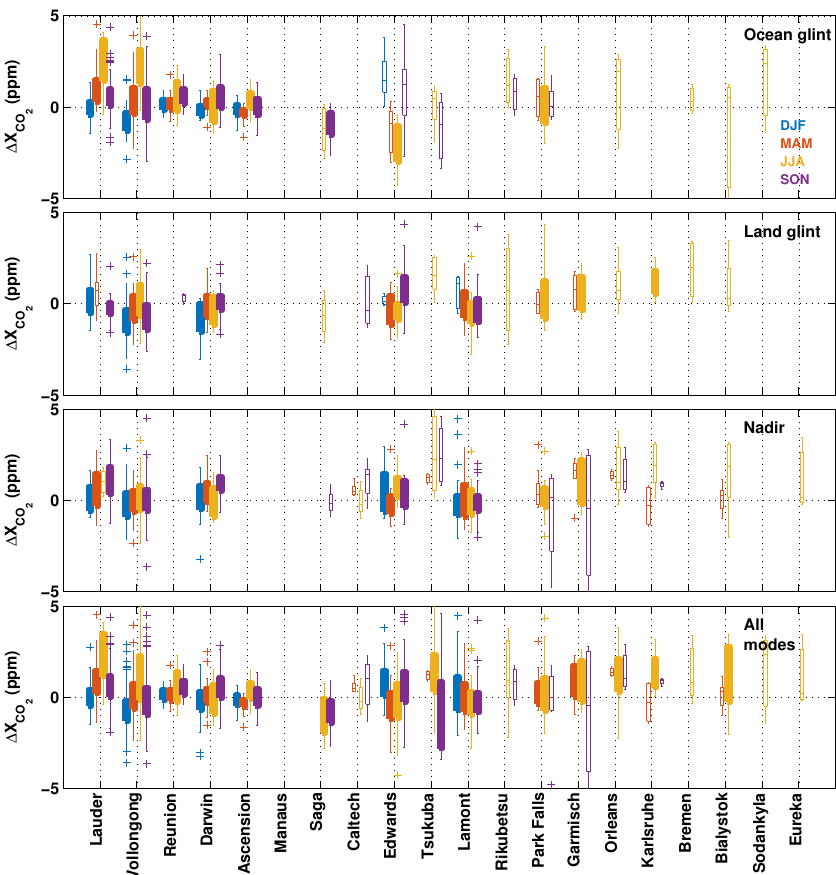
Figure 11. The dependence of the difference between OCO-2 X CO observing mode. This is a box plot akin to Fig. 6. The filled boxes indicate seasons for which there are > 10 comparison points between OCO-2 and TCCON; the thin boxes contain at least 3 comparison points. Any site and season for which there were fewer than three com- parison points were excluded from the plot. The different colors indicate the different seasons (blue = DJF, orange = MAM, yellow = JJA, purple = SON). The TCCON stations are ordered by latitude, where Lauder is 45 ◦ S and Eureka is 80 ◦ N. The equator is between